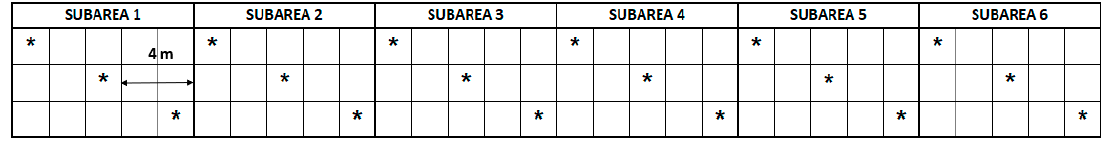
Figure 7. Field area divided into six subareas (SBs). The Asterix (‘*’) indicates the sampling point for soils collected at the end of each year.